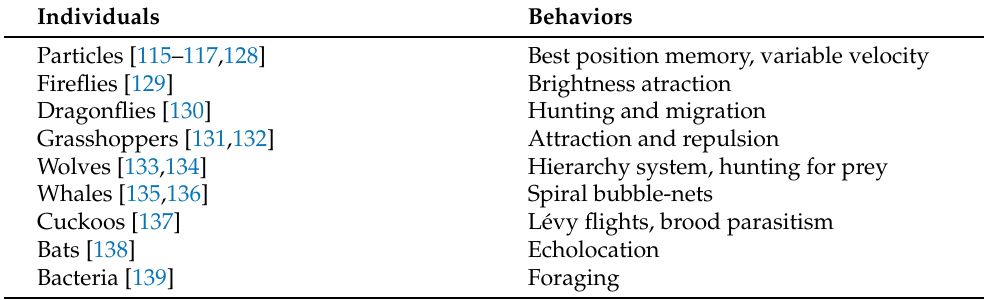
Table 2. Intelligent models used for some swarm algorithms, together with some of the models.